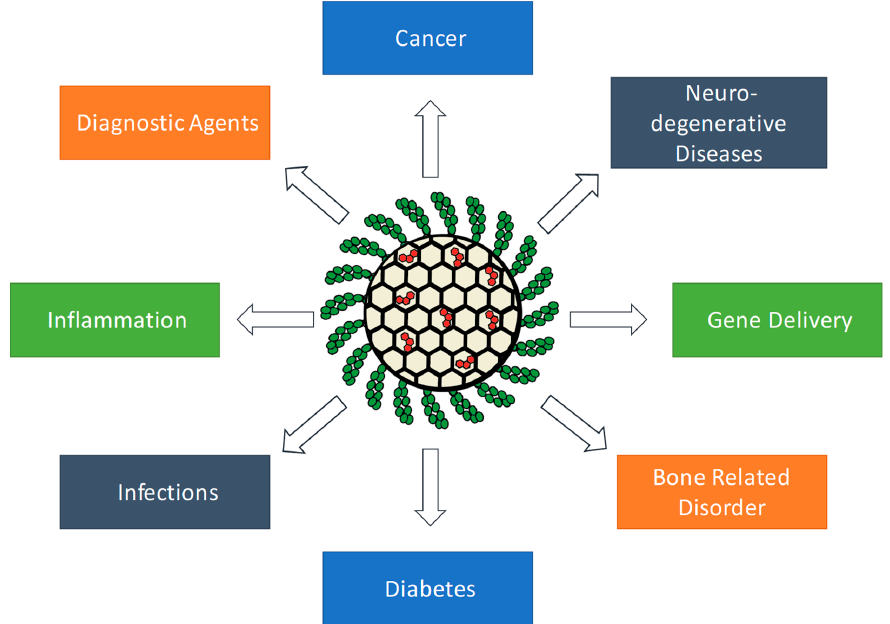
Figure 3. Biological disorders that have been targeted using polymer coated mesoporous silica